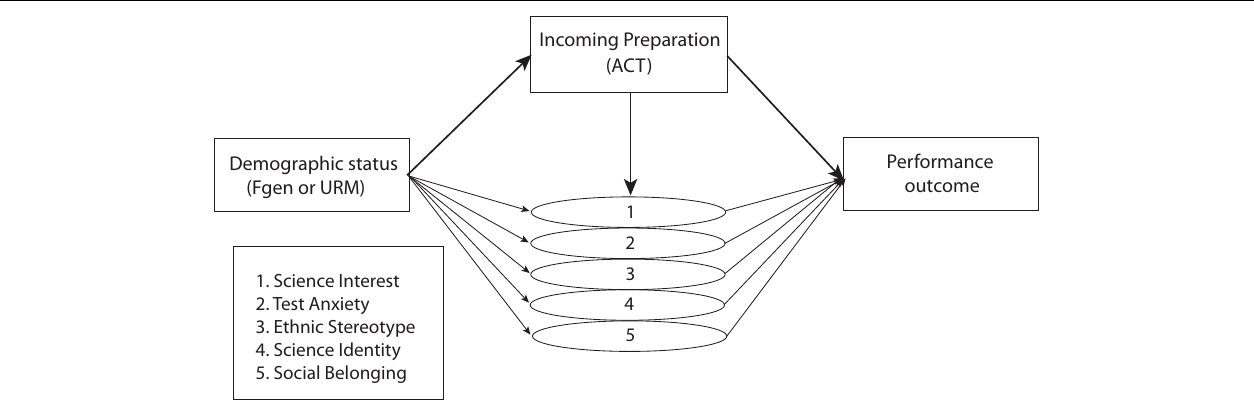
FIGURE 3 | Mediation structure for the effect of demographic status on student performance. In this structure, incoming preparation as measured by ACT composite and each of the five social psychological factors are tested as separate mediators for the effect of student demographic status (first-generation status, or Fgen, and underrepresented minority status, or URM) on performance on exams or total grade.